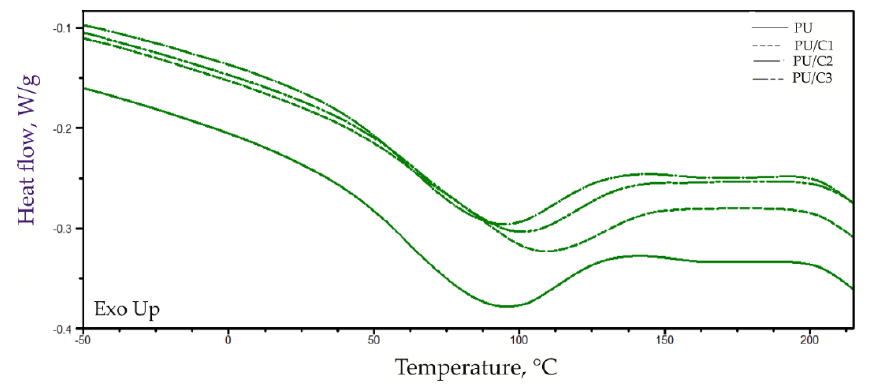
Figure 12. Curves of TG, DTG, and DSC analysis of PU foam. Figure 13. Curves of DSC analysis of PU foams in the first cycle analysis. Figure 13. Curves of DSC analysis of PU foams in the first cycle